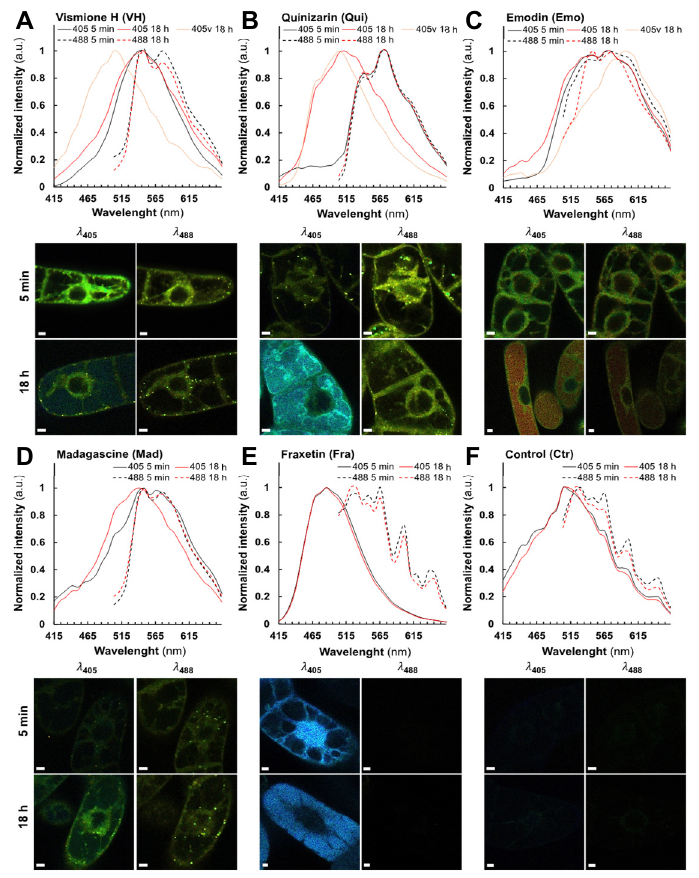
Figure 4. Fluorescence spectra and images of BY-2 cells treated by 25 µ M of phenolic compounds prior to observation using SImaging. Normalized fluorescence average spectra and lambda view images from SImaging analysis at λ 405 (solid line) and λ 488 (dashed line) of BY-2 cells treated for 5 min and 18 h with 25 µ M of ( A ) vismione H, ( B ) quinizarin, ( C ) emodin, ( D ) madagascine, ( E ) fraxetin, and ( F ) the negative control without treatment. Spectra observed after 5 min (black), after 18 h (red) and in the vacuole after 18 h (red light). Spectra observed in the primary vacuole at λ 405 after 18 h are specified with a “v” after the labels if another fluorescence was observed in the cytoplasm. Bars = 20 µ